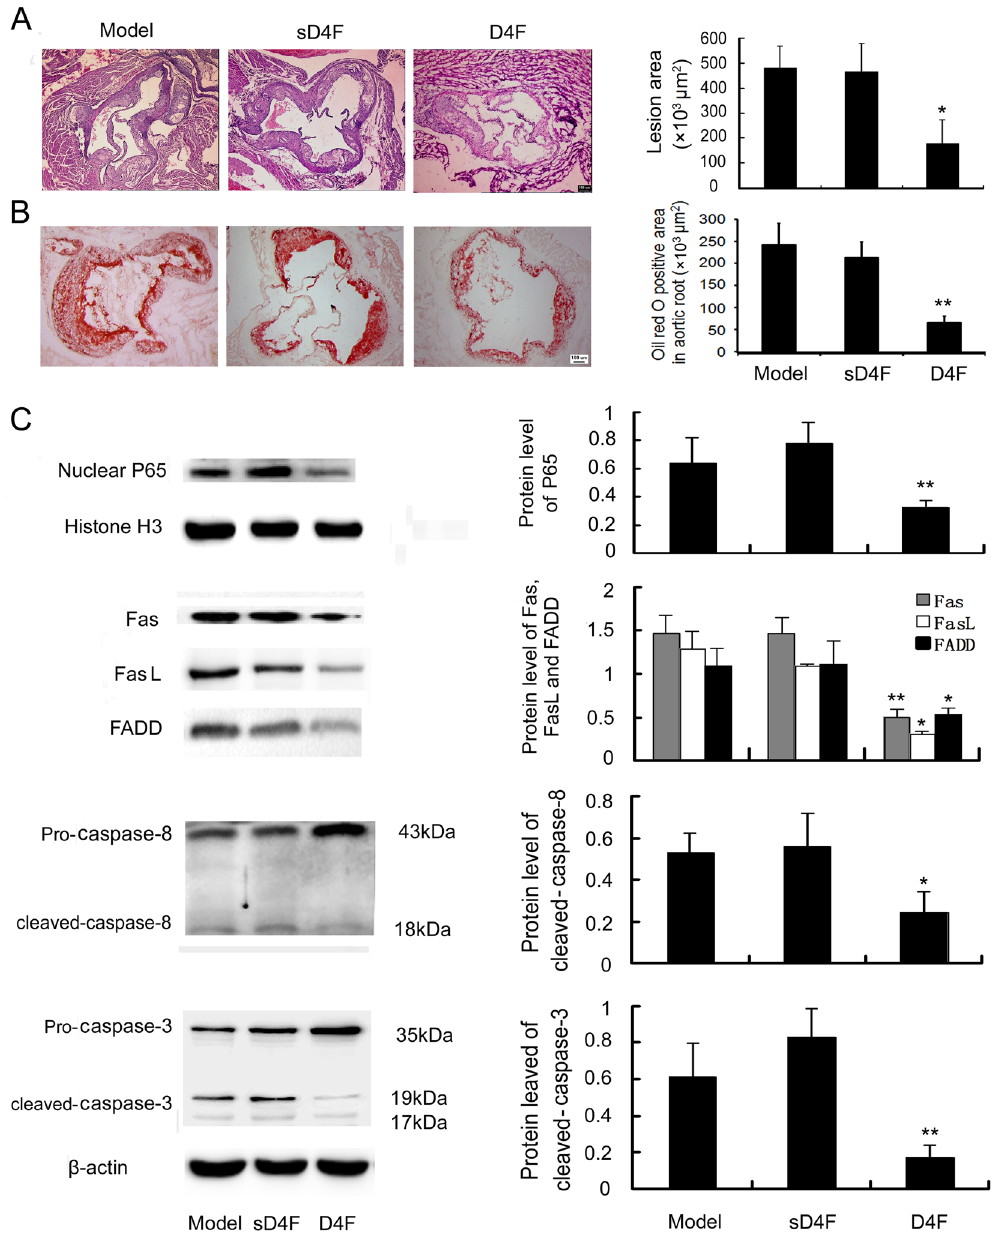
Figure 5. D4F reduces the atherosclerotic lesion area in aortic root and downregulates the expression of P65 and Fas/FasL pathway-related molecules in thoracic aorta. Male apoE − / − mice were fed a high-fat diet for 8 weeks and given saline (model group, n = 8), 1 mg/kg sD4F (sD4F group, n = 8) or 1 mg/kg D4F (D4F group, n = 8) per day by intraperitoneal injection during the final 6 weeks. ( A ) Atherosclerotic lesion formation shown with HE staining. Scale bar = 100 μ m. ( B ) Atherosclerotic lesion formation stained by oil red O. Scale bar = 100 μ m. ( C ) Western blot results showing the protein levels of P65 and Fas/FasL pathway-related molecules in thoracic aorta. Data are expressed as the mean ± SD of at least three independent experiments. * P < 0.05 and ** P < 0.01 versus model